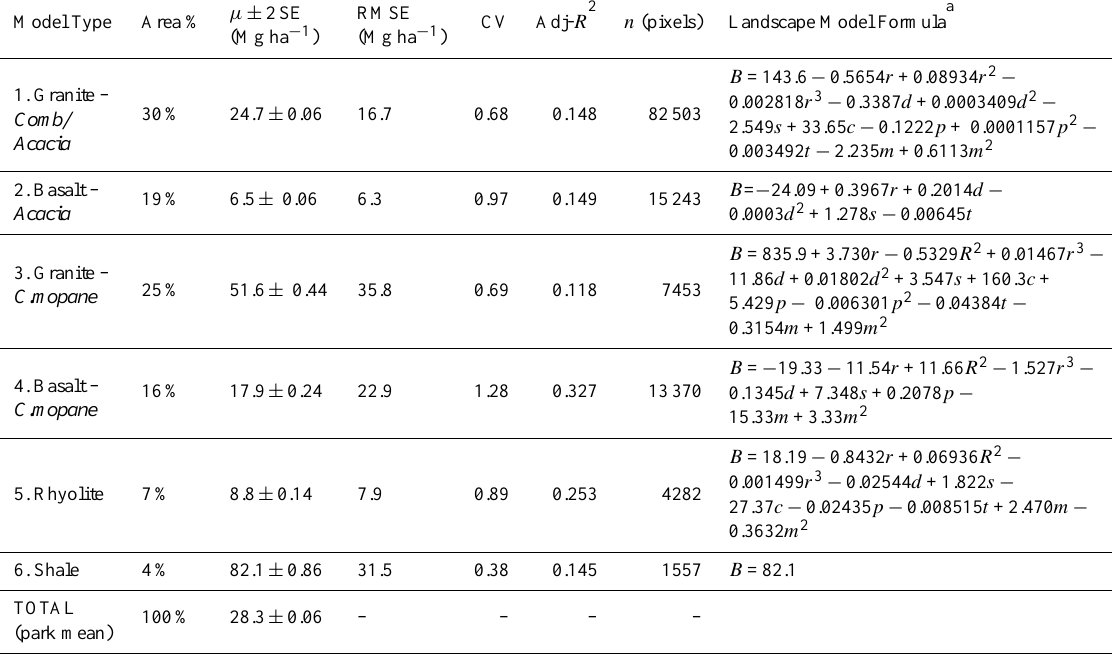
a Multivariate, non-linear models for predicting AGB using landscape-only variables at 0.5ha scale. Variable legend: B =aboveground wood biomass (Mgha − 1 ) , r =elevation above nearest stream (m), d =elevation above sea level (m), s =slope (deg), c =profile curvature (deg m − 1 ) , p =precipitation (mmyr − 1 ), t =stream distance (m), and m =Strahler stream order of nearest